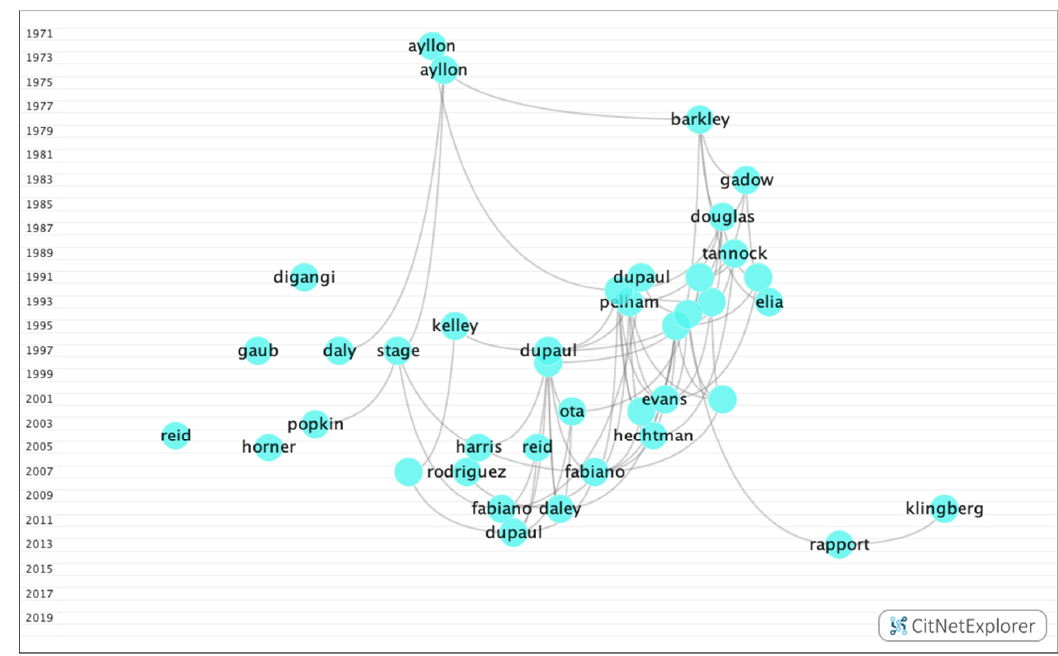
Figure 14. Group 8 citation network.